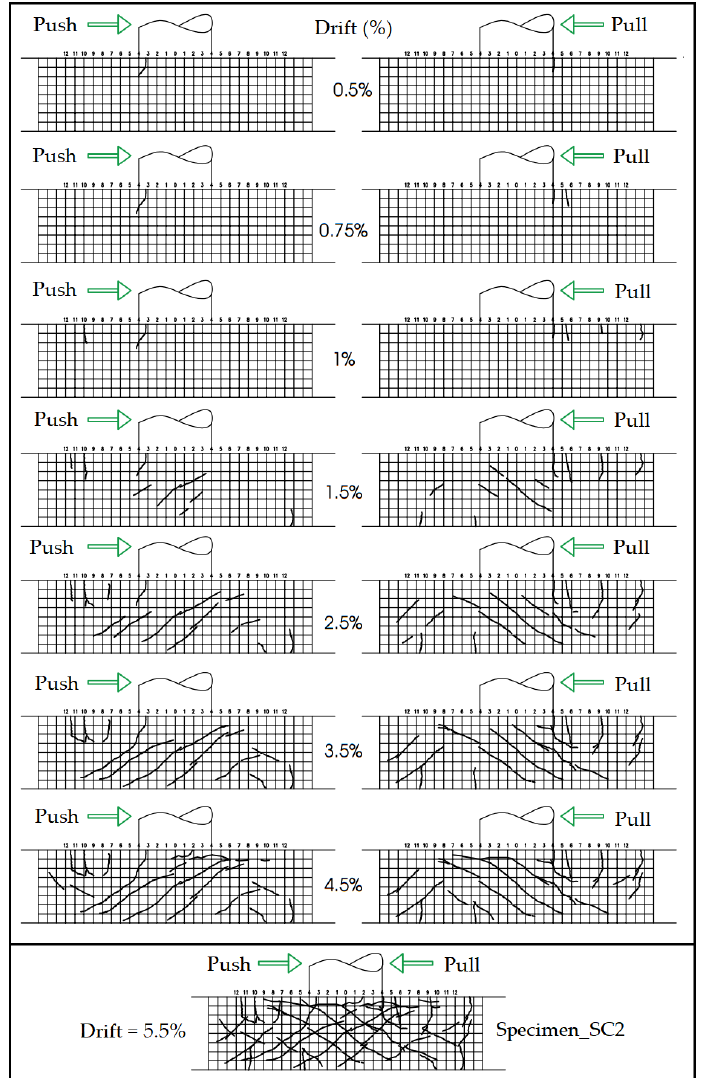
Figure 8. Crack pattern of specimen SC2.